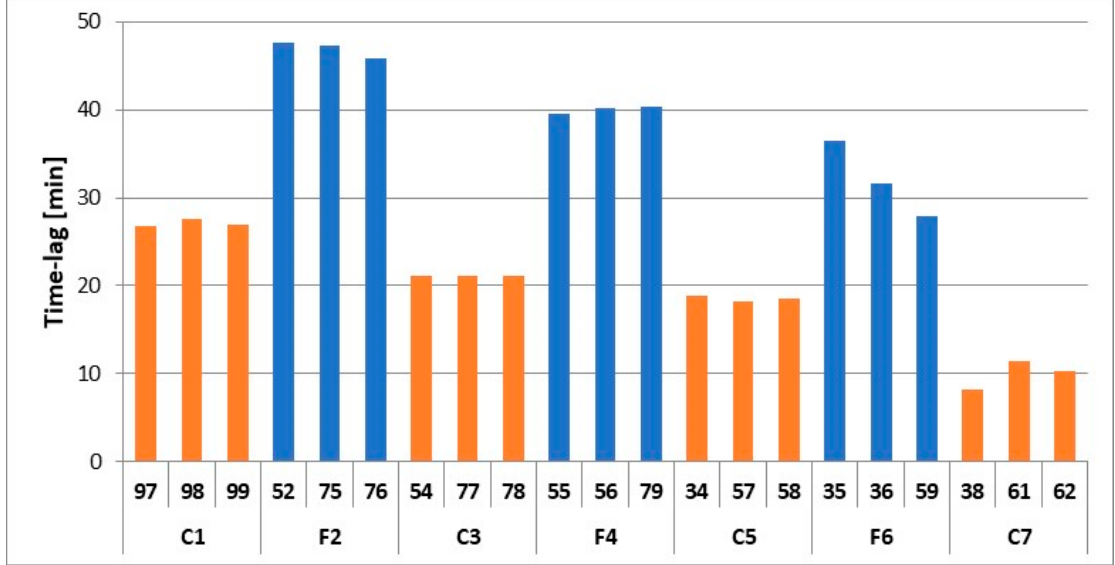
Figure 6. Time lags of EC oscillations at several sensors relative to head oscillations at the boundary in E2-120. Sensor locations are shown in Figure 1.